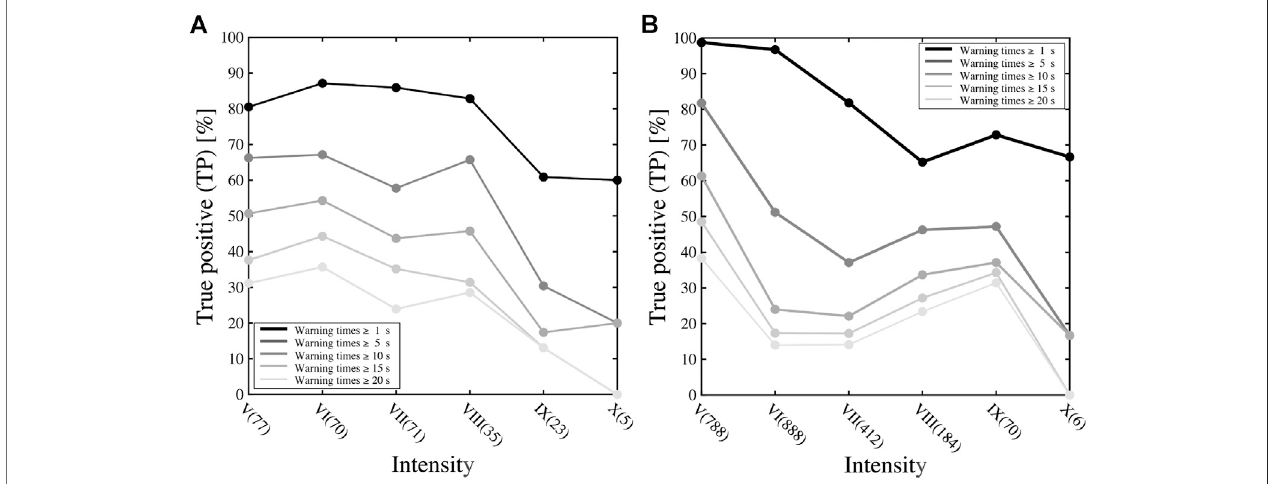
FIGURE13| Percentageoftruepositives(TP)fordifferentlevelsofintensity(bothChineseandMMIscale)anddifferentrangesofwarningtimeusingFinDermodels for the (A) current network (dataset 1) and (B) future network (dataset 2). Numbers in brackets on x -axis give station counts for each intensity bin.